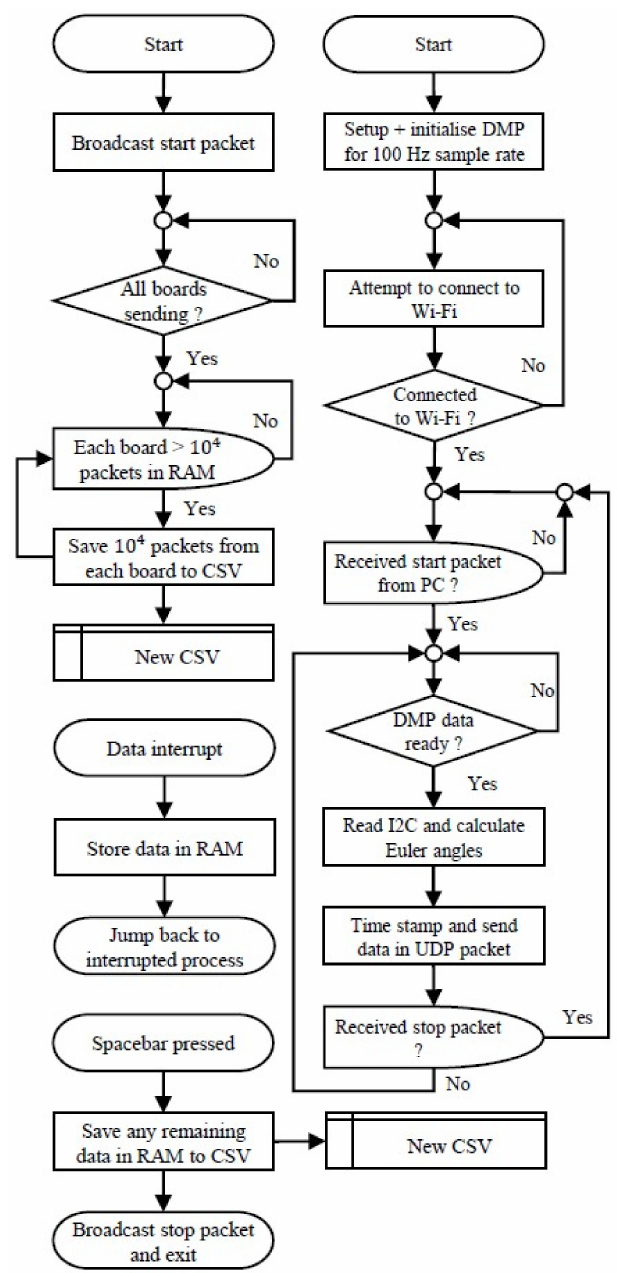
Figure 6. Flow chart describing the Java code that runs on the computer in Processing (top left), two of the interrupts for the Java code (bottom left) and the Arduino code (right) that run on the MKR1000(s). The ’All boards sending?’ block also relies on an interrupt process but the details are